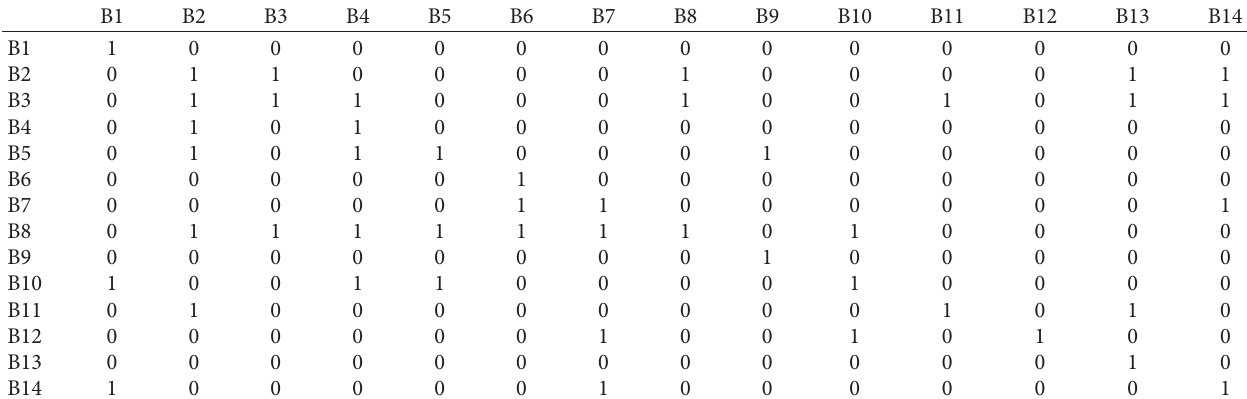
Table 5: Adjacency matrix.